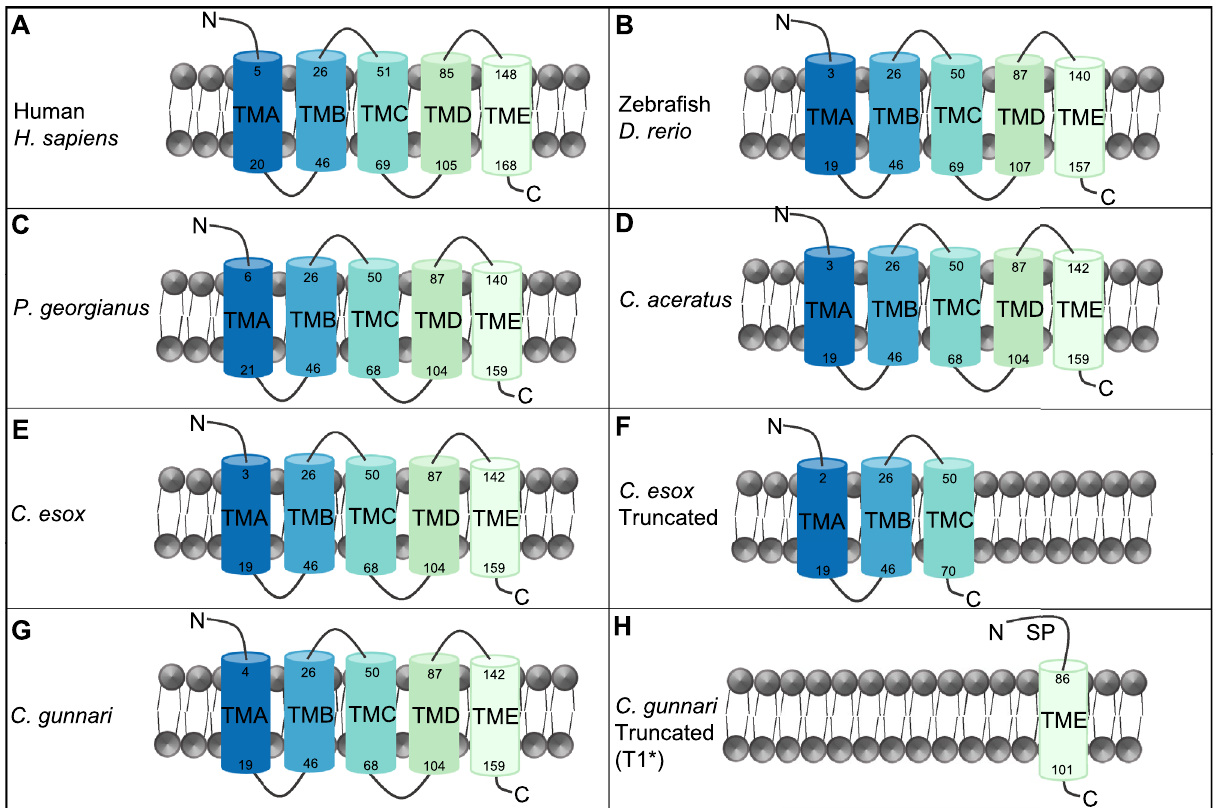
Figure 2. Protein structure of complete ND6 proteins contain five transmembrane proteins (TMA-TME). Protein structure of a complete ND6 protein in ( A ). Human, ( B ) Zebrafish, ( C ) P. georgianus , ( D ) C. aceratus , and ( E ) wildtype C. esox . ( F )Protein structure of a truncated ND6 protein in C. esox , where the protein structure terminates near the midpoint of complete ND6 protein retaining wildtype structure of the N-terminal half of ND6 through TMC. ( G ) Protein structure of a complete wild type ND6 in C. gunnari . ( H ) Protein structure of truncated copy of ND6-T1 in C. gunnari where the C-terminal half with one transmembrane TME is retained along with predicted signal peptide (SP) at the N-terminal end. Only T1 truncation is shown as T2 is likely pseudogenized as the transcript is too short to allow for structure